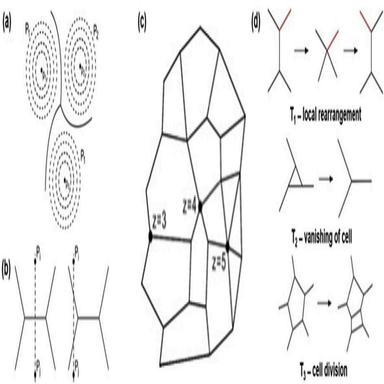
(a) Organizing centers on a plane and (b) saddle-minimum graph of the d^ function. (c) Cellular structure in two dimensions: z is coordination number, i.e., the number of edges joined to a given vertex. (d) Elementary processes T1, T2, and T3 by which cellular structure might change, preserving the equilibrium z ¼ 3 (Euler formula).